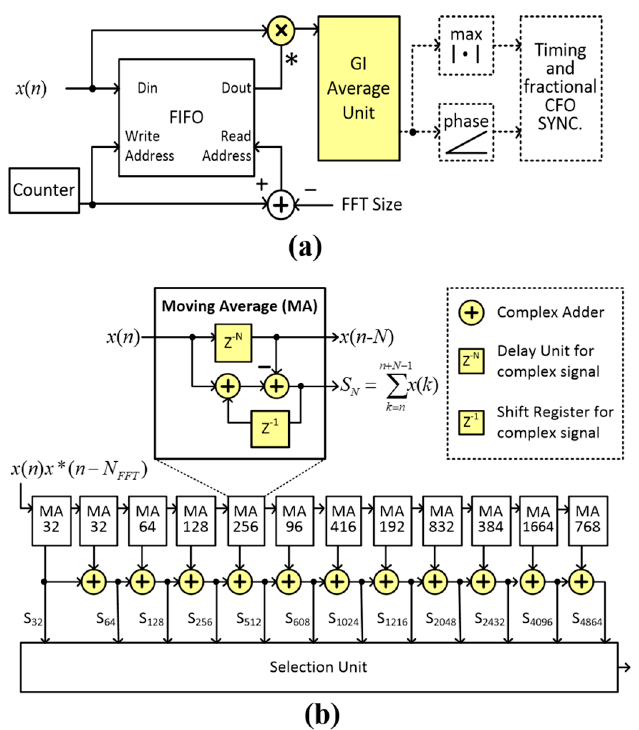
Figure 10. Block diagram of ( a ) the GI detector and ( b ) the proposed GI average unit.